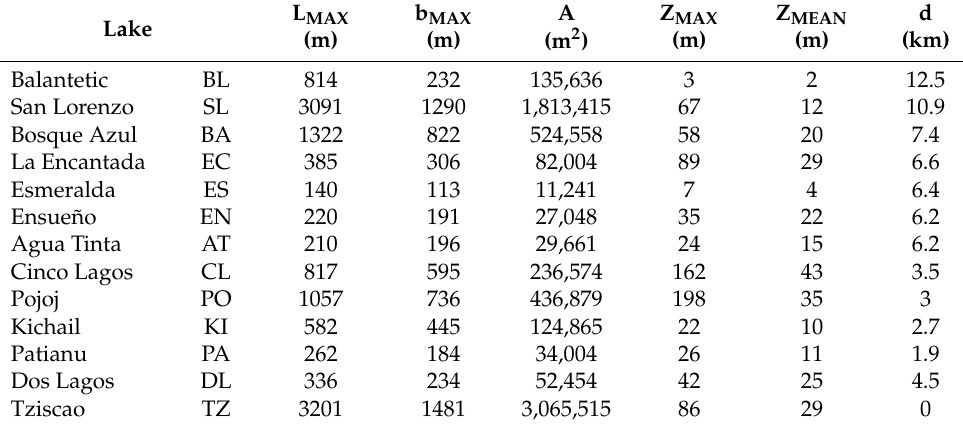
Table 1. Morphometric parameters of the Lakes of Montebello (Alcocer et al. [41]): L MAX , maximum length; b MAX , maximum width; A, surface area; Z MAX , maximum depth; Z MEAN , mean depth; d, straight-line distance between each lake and Lake Tziscao at the extreme SE; lakes from NW to SE. L MAX b Lake